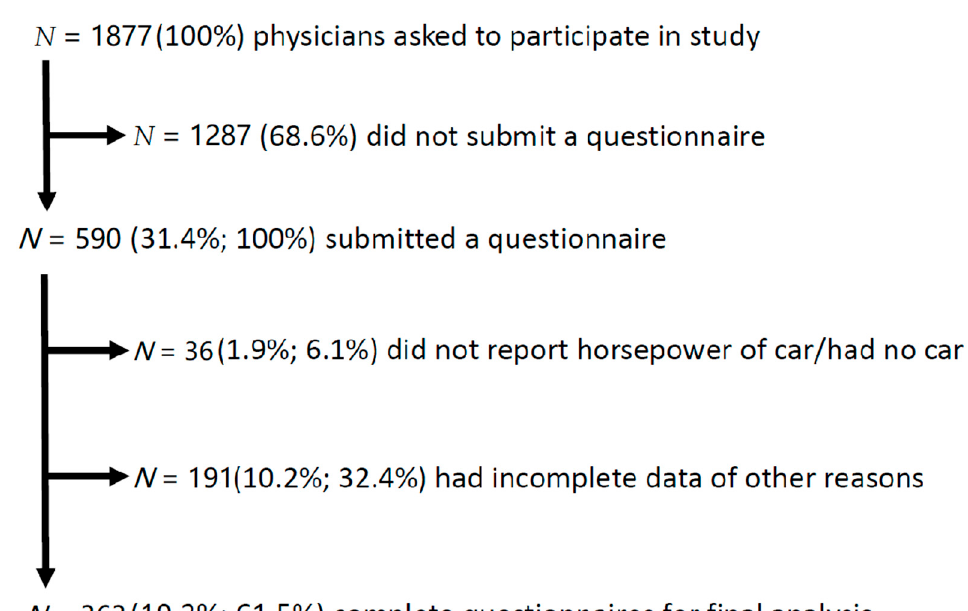
Figure 1. Flow chart of participating physicians of the study.